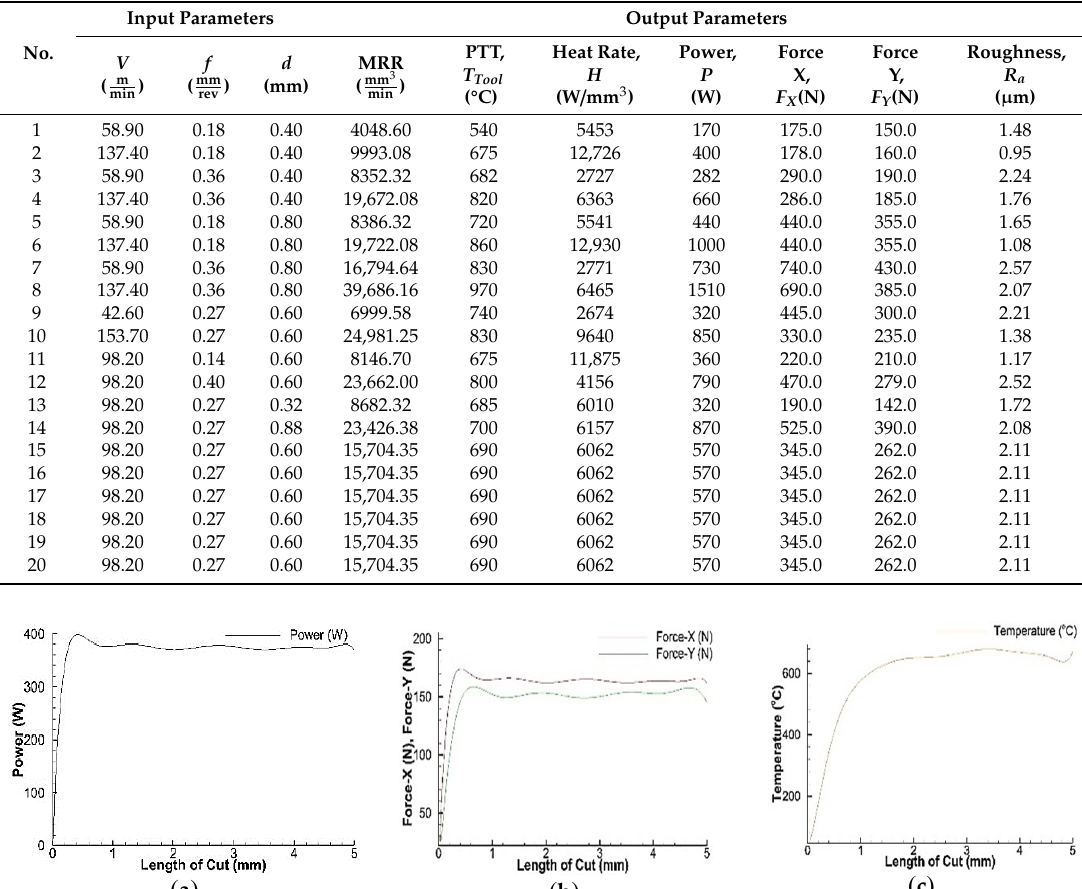
Table 4. Experimental and simulation results.